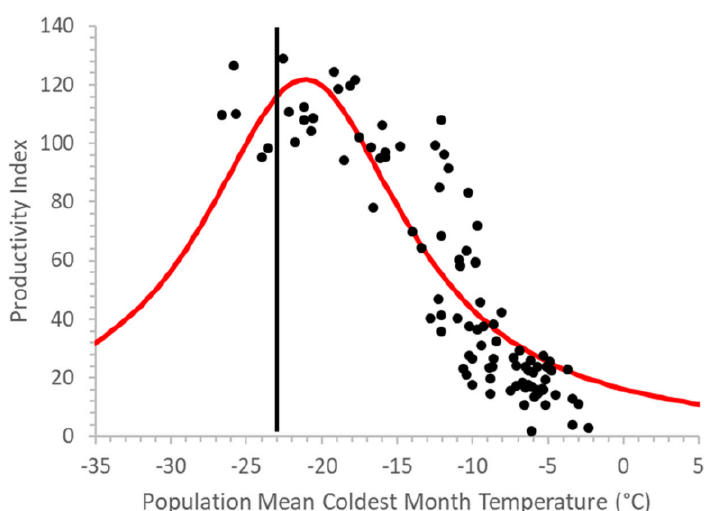
Figure 3. Genecology function for a provenance test site near the town of High Level, Alberta, showing that the most productive populations at the High Level site are those that originate from locations having a mean coldest month temperature (MCMT) approximately 3 ◦ C warmer than the plantation. The vertical bar identifies the MCMT of High Level, Alberta ( − 23 ◦